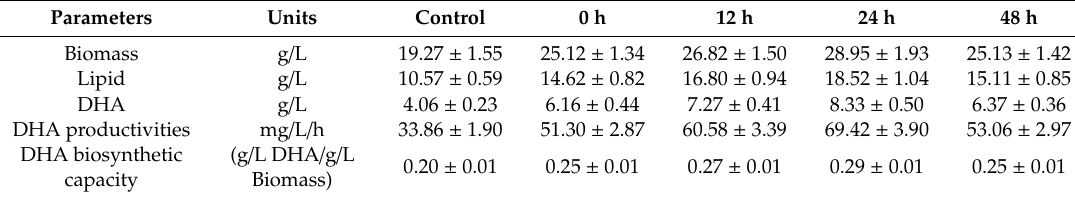
Figure 3. The impact of the synergistic optimal concentration of KIN, JA and GA on biomass ( A ), lipid ( B , C ) and DHA ( E , F ) at the 0, 12, 24 and 48 h feeding points in SW1.Values and error bars represent the means and the standard deviations of triplicate experiments ( n = 3). Table 3. Comparison of biomass, lipid, DHA content, yield and biosynthetic capacity of SW1 after 120 h of cultivation supplemented with the synergistic optimal concentration of KIN, JA and GA at di ff erent time points. Values and standard deviations represent the mean data of triplicate experiments ( n =